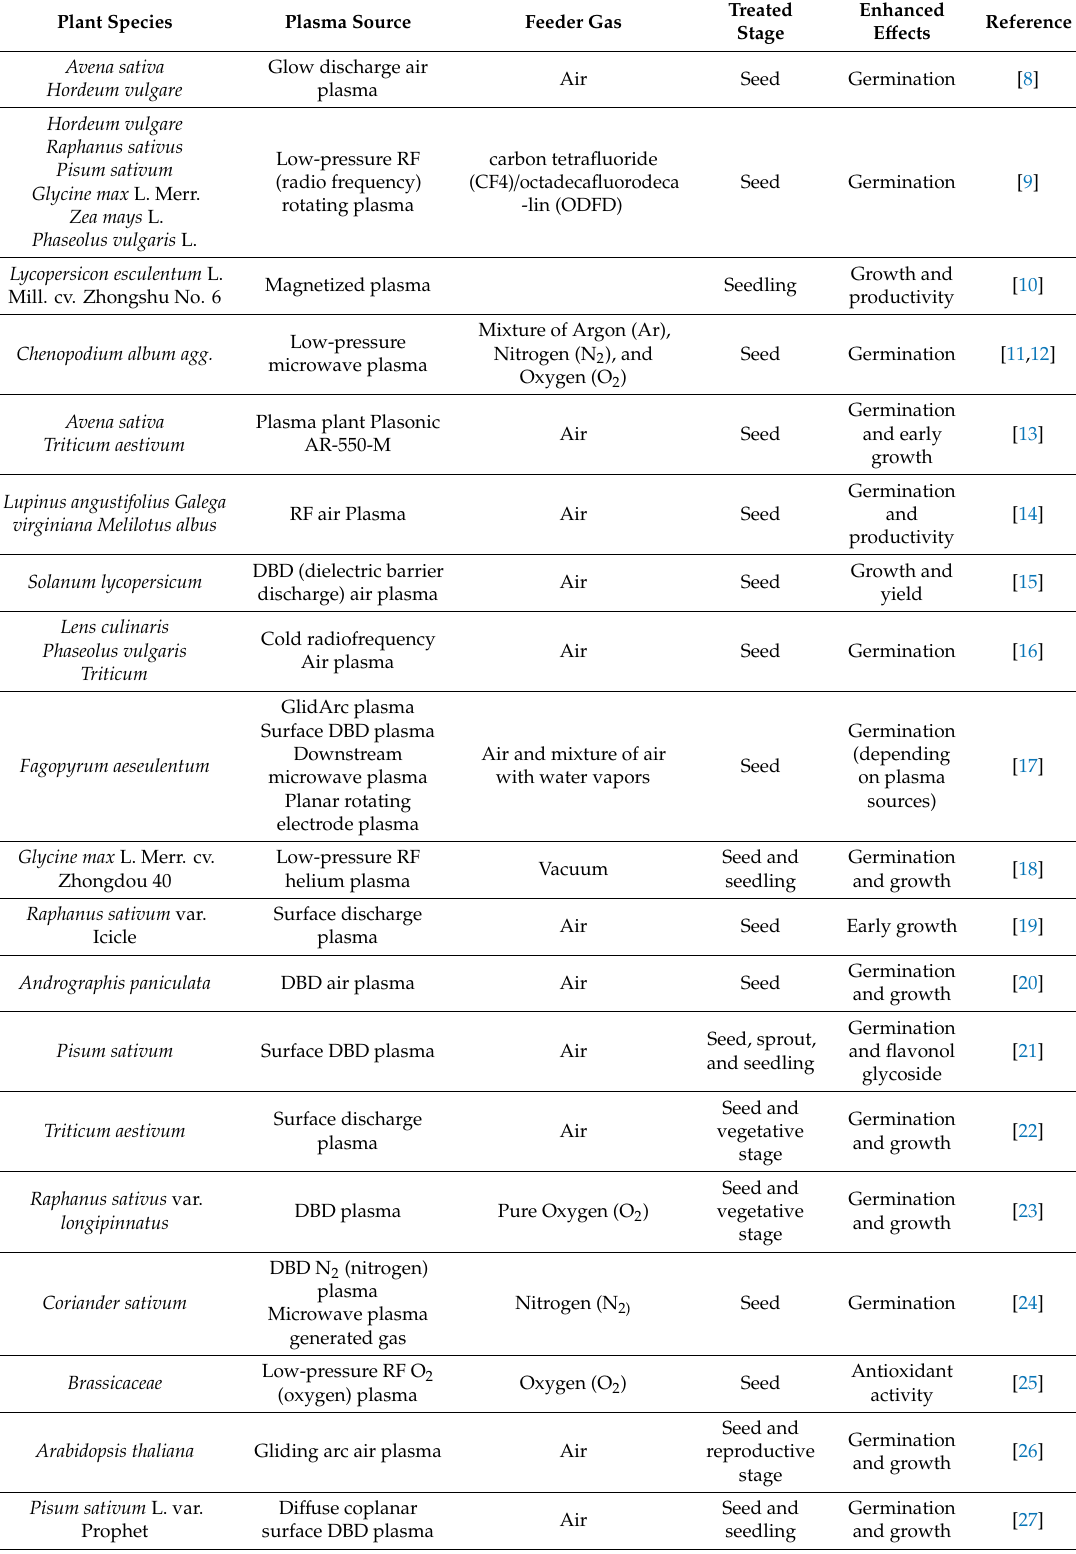
Table 1. E ff ects of direct plasma on plant germination, growth, and